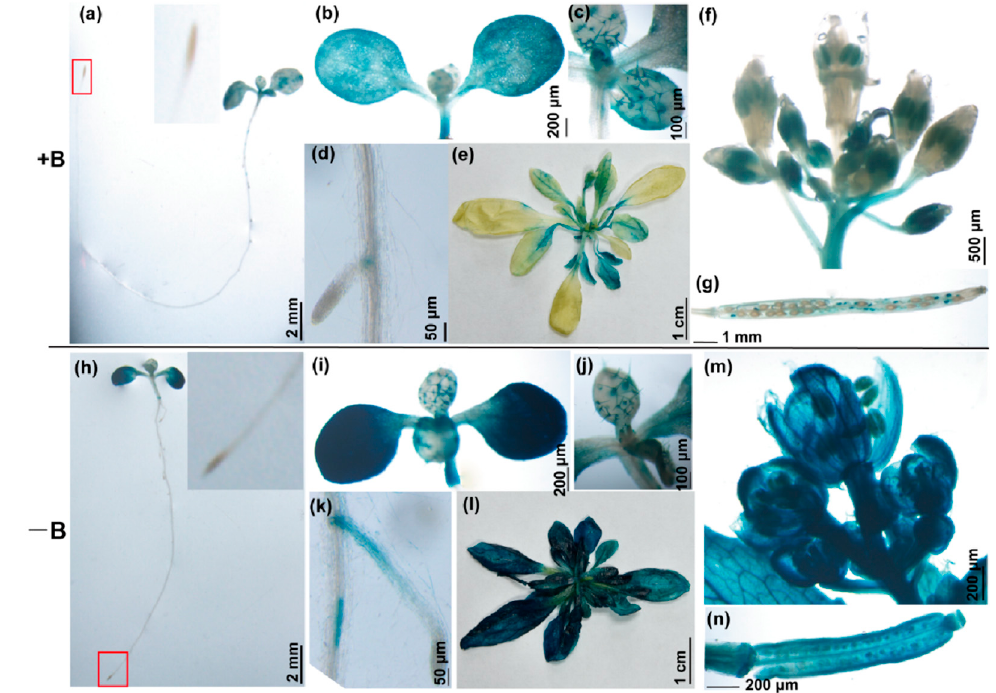
Figure 1. GUS staining pattern in different organs and tissues of AtTCH4 in Arabidopsis under different B conditions. ( a – g ) and ( h – n ) The transgenic plants were grown for 7 d at the seedling stage and 40 d at the flowering stage under B-sufficient (100 μ M B) and B-deficient (0.1 μ M B) conditions, respectively. ( a , h ) Whole seedling plants. The root tips in the red box are enlarged. ( b , i ) Cotyledon. ( c , j ) Leaf trichome. ( d , k ) Lateral root node. ( e , l ) Rosette leaf. ( f , m ) Flower. ( g , n ) Siliques. To clarify the subcellular localization of TCH4, pTCH4:TCH4-GFP transgenic